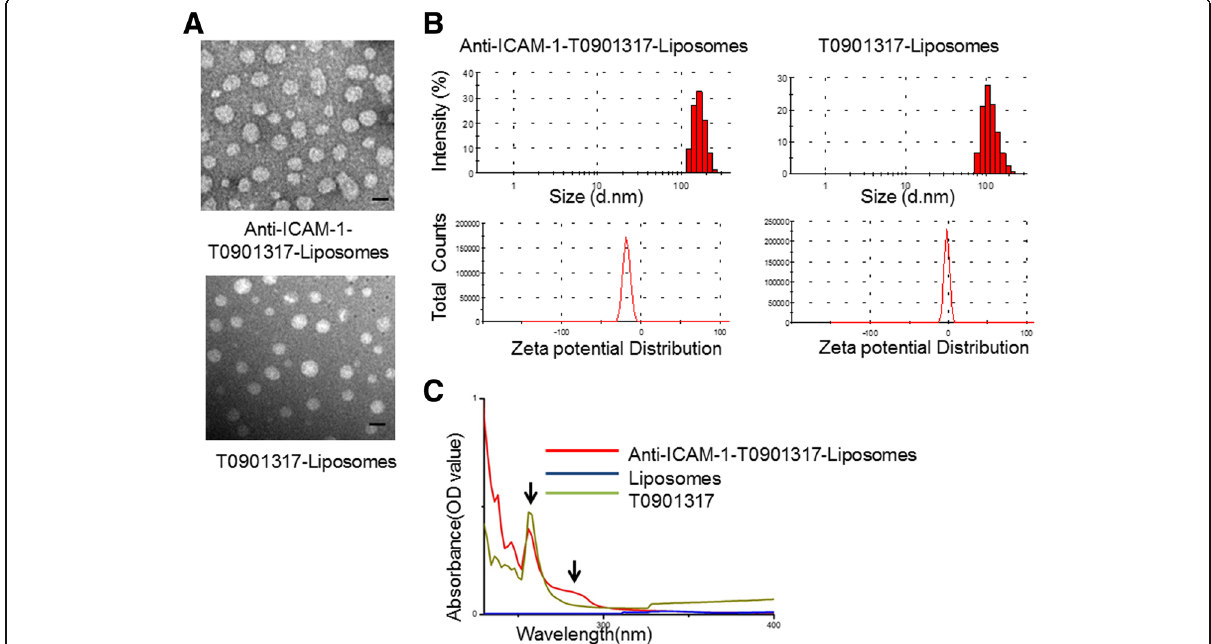
Fig. 2 Characterisation of nanoparticles. a The picture above is the TEM image of the antibody T0901310 liposomes. And the photo below is the TEM image of the T0901310- liposomes. Bar = 100 nm. b Hydrodynamic diameter and zeta potentials for antibody T0901317 liposomes and T0901317 liposomes. c UV-visible absorption values of anti-ICAM-1-T0901317- liposomes, control liposomes, and T0901317 liposomes. And the different DLS size changes of these liposomes in different pH values are shown in Additional file 1: Figure